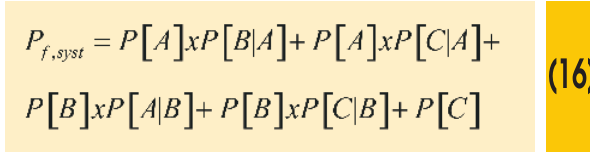
Figure 6 – Tree of failure for the beam